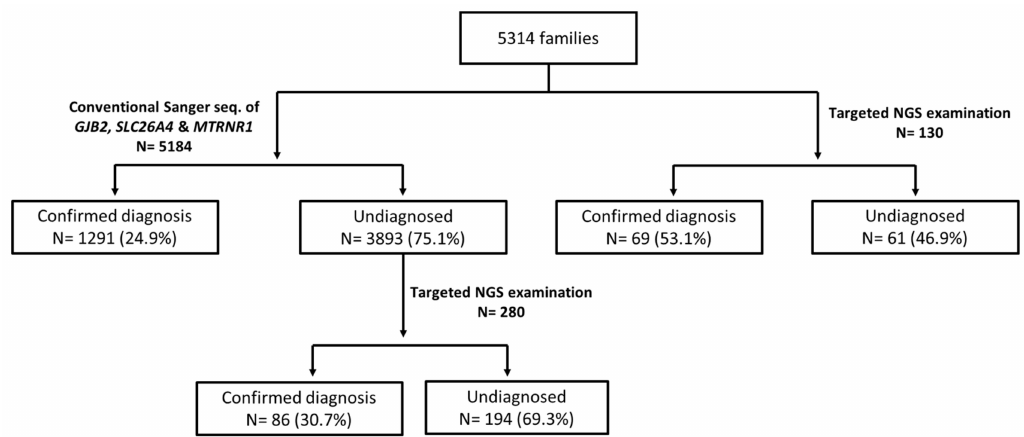
Figure 1. Summary of the genetic results in the 5314 Taiwanese families included in this study.